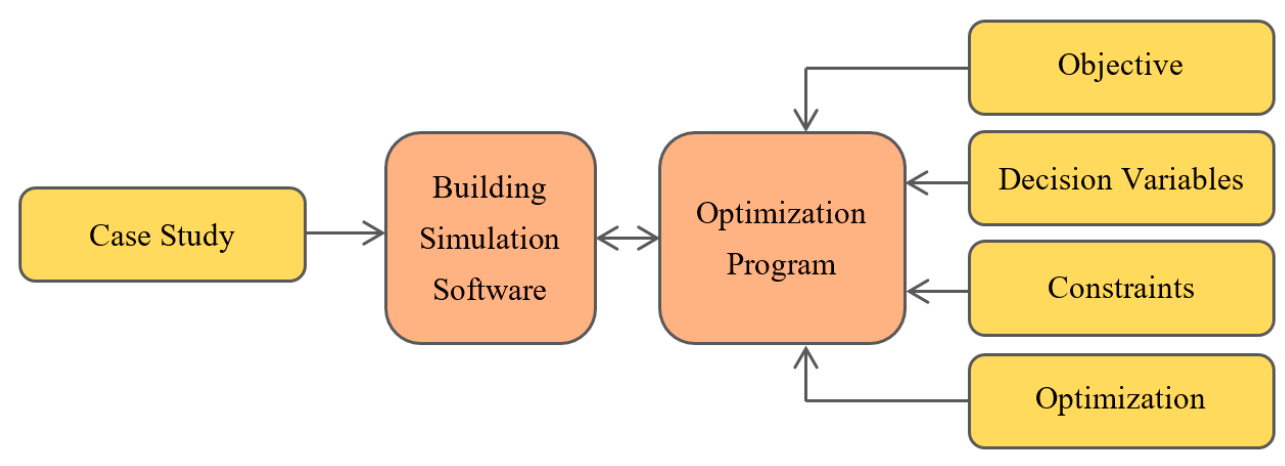
Figure 3. The BPO procedure.